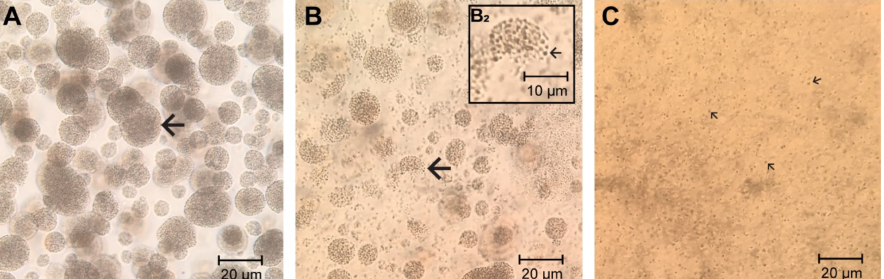
Figure A1. Microscopic pictures of β -glucan containing material from the Saccharomyces cerevisiae cell wall (Macrogard, Or ff a). ( A ) In an aquatic suspension the β -glucan forms aggregates of macroparticulates (arrow) ( B ) β -glucan macroparticulates resuspended in 0.03 M NaOH and heated at 70 ◦ C for 2.5 h. The aggregates starting to fall apart (arrow) into microparticulates. ( B 2 ) Closeup of a singular aggregate falling apart into individual microparticulates (arrow). ( C ) Homogeneous microparticulates suspension containing only individual β -glucan microparticulates (arrows). The suspension was created by using a sterile syringe by drawing the suspension of ( B ) up and down 2 times. Size bars are shown in the figures. Microscope magnification = 200 × , using an inverted microscope (Zeiss Primovert Inverted Microscope, Carl Zeiss Microscopy GmbH,